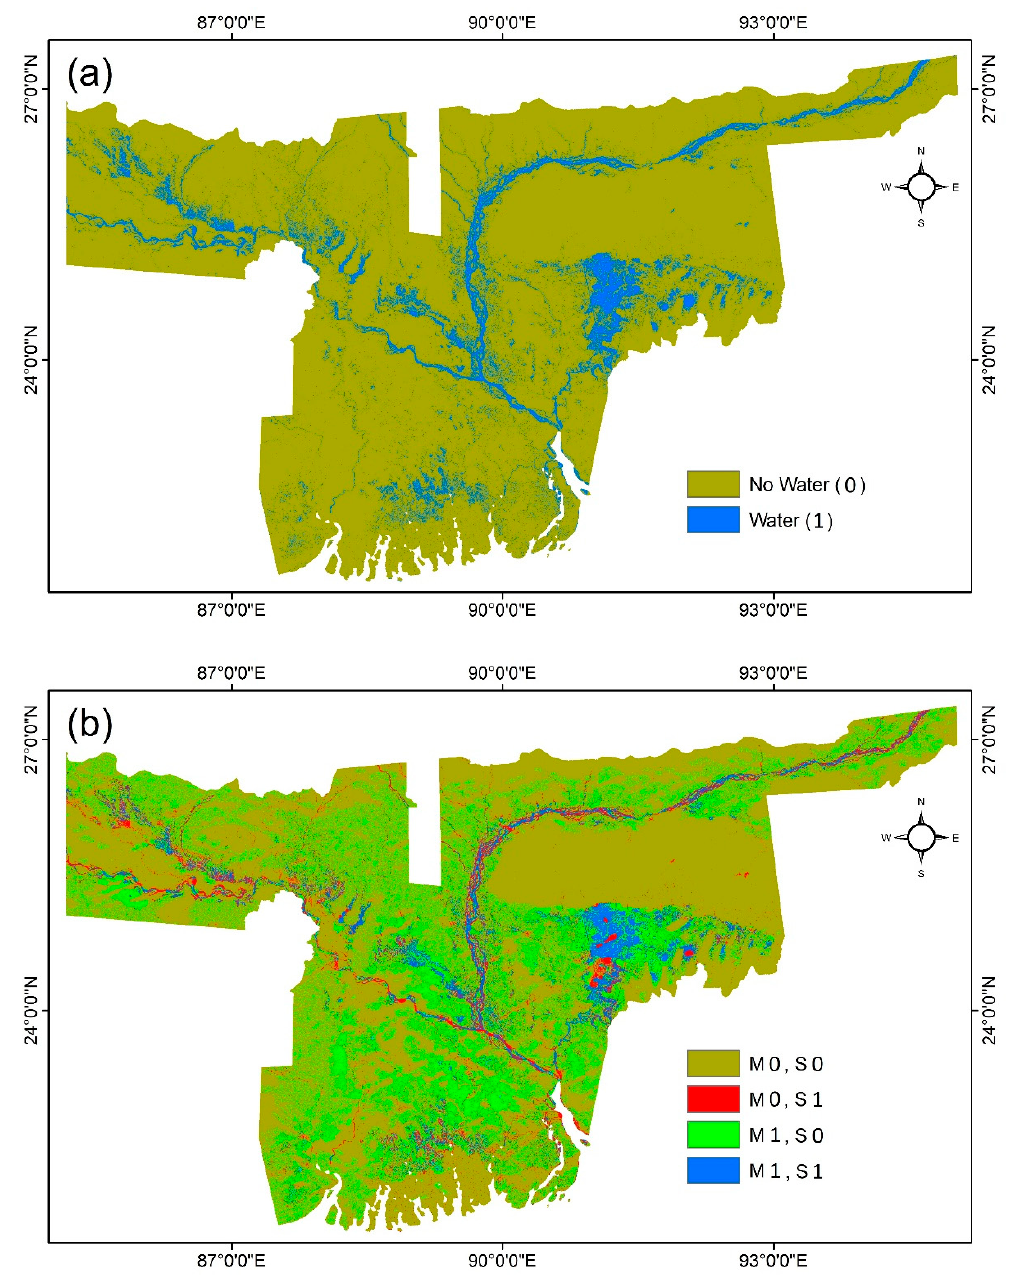
Figure 7. ( a ) Flood inundation derived from Sentinel-1 SAR imagery; and ( b ) model (M) output for threshold 15 and Sentinel (S) flood inundation maps (water—1, and no water—0) overlaid on each other over North India for August 2017.